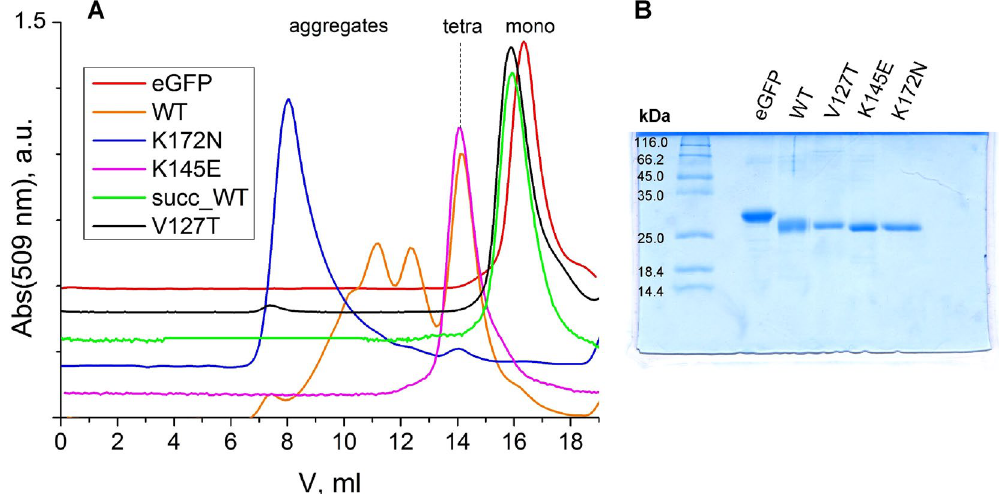
Figure 2. ( A ) Size-exclusion chromatography of different SAASoti mutants, succinylated SAASoti and eGFP (monomer control). Superdex G200 100/20 GL column, buffer Tris-HCl 100 mM, CaCl2 10 mM, pH 7.6, detection by absorption at 509 nm; ( B ) PageBlue stained 4–15% SDS-PAGE after all protein purification procedures. Lanes: kDa- SM0431 Fermentas calibration kit; 1 – eGFP; 2 – wild type SAASoti; 3 – V127T SAASoti; 4 – K145E SAASoti; 5 – K172N